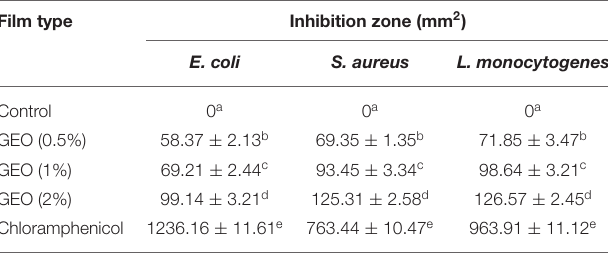
TABLE 4 | Antibacterial activities of the cassava starch-based film against Gram-negative and Gram-positive bacteria. Film type